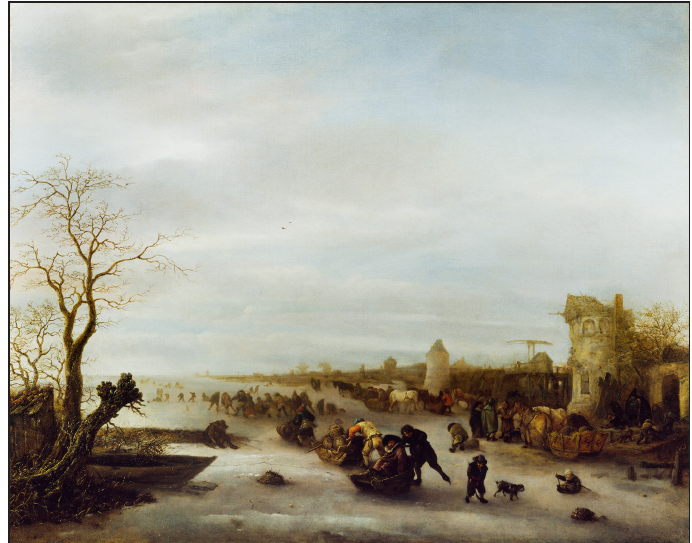
Fig. 10 : Isack van Ostade, A Winter Scene , 1640s, oil on canvas, 86.4 × 107.5 cm, Wallace Collection, P73. © The Trustees of the Wallace Collection,